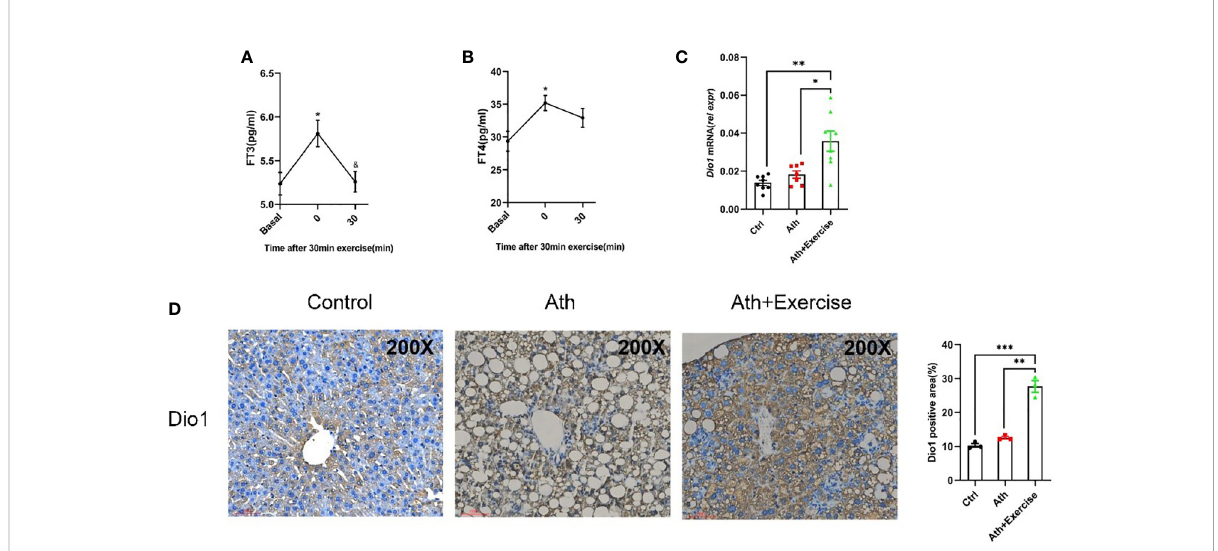
FIGURE 6 Aerobic exercise increased Dio1 levels in the liver of NASH mice and increased FT3 and FT4 levels in serum. (A) The effect of an exercise training on FT3 in mice serum. (B) The effect of an exercise training on FT4 in mice serum. (C) Aerobic exercise increases the expression of Dio1 in the liver of NASH+exercise mice as veri fi ed by q-PCR. (D) Immunohistochemistry straining of Dio1 in liver tissues from control, NASH and NASH +Exercise mice (original magni fi cation, ×200). Data are depicted in mean ± SEM. *P<0.05; **P<0.01;